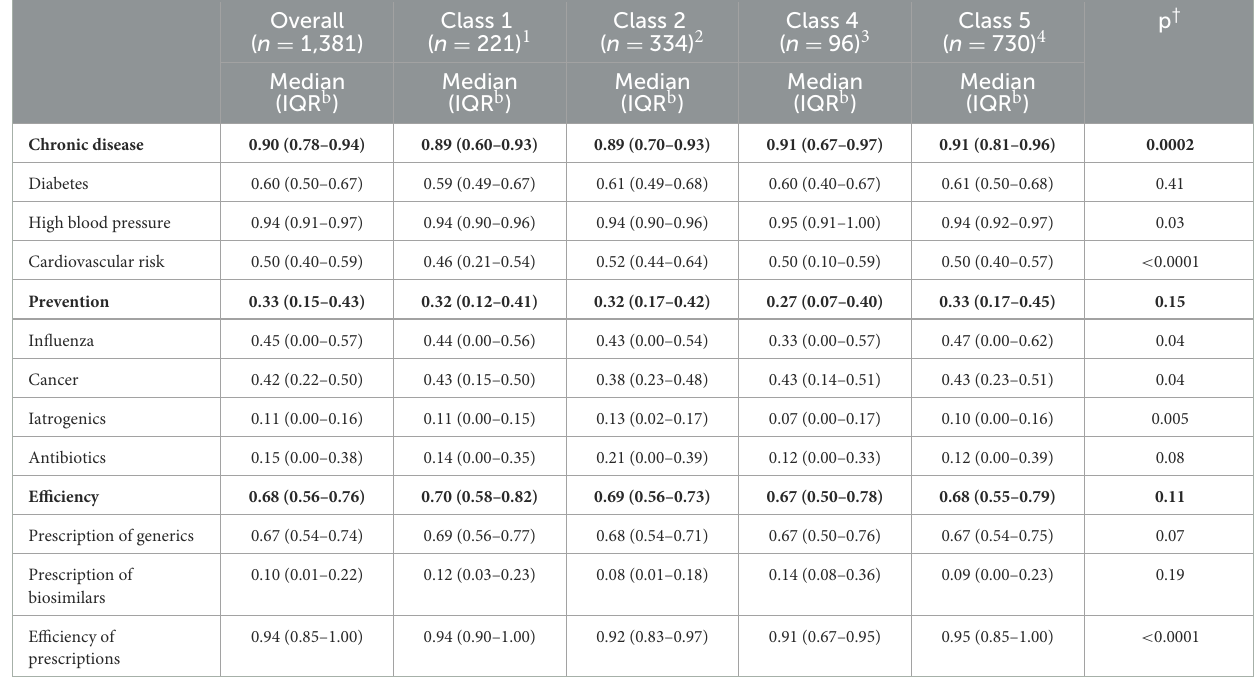
TABLE 5 Comparison of the territories within the Aube department from 2017 to 2020 according to the IRDES a